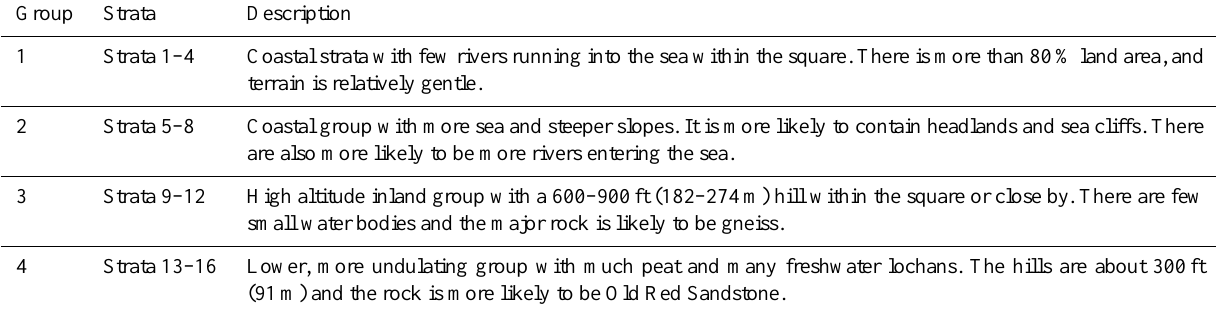
Table 1. Description of strata.